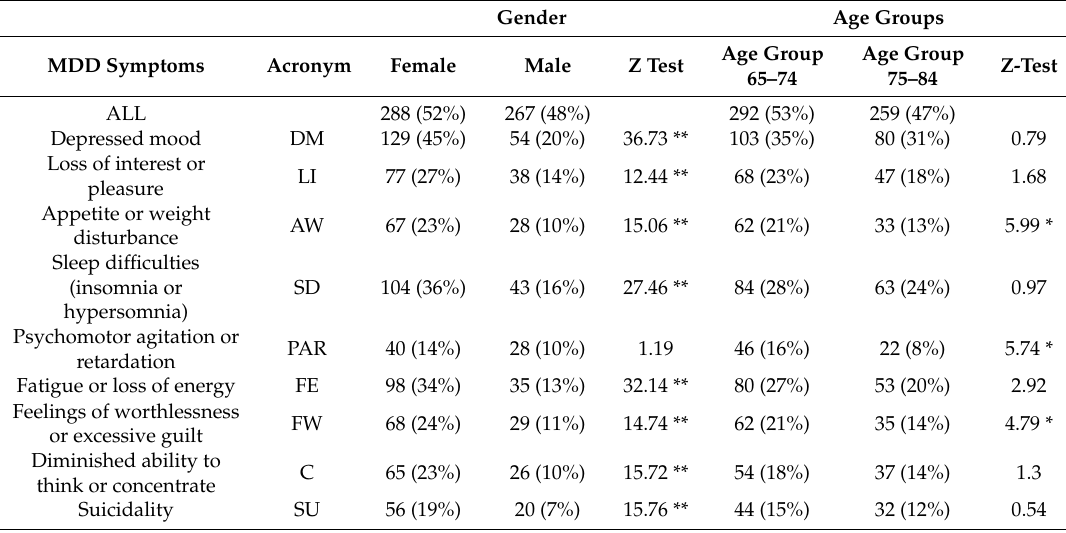
Table 2. Frequencies and percentages of symptoms for gender and age variables in the